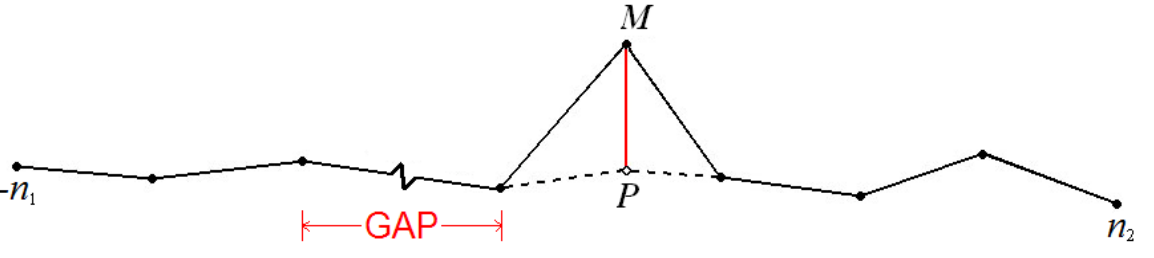
Figure 3. Time series of points with an appreciable gap between two neighboring points. As the gap increases, the likelihood that the predicted measurement (P) represents the true value,